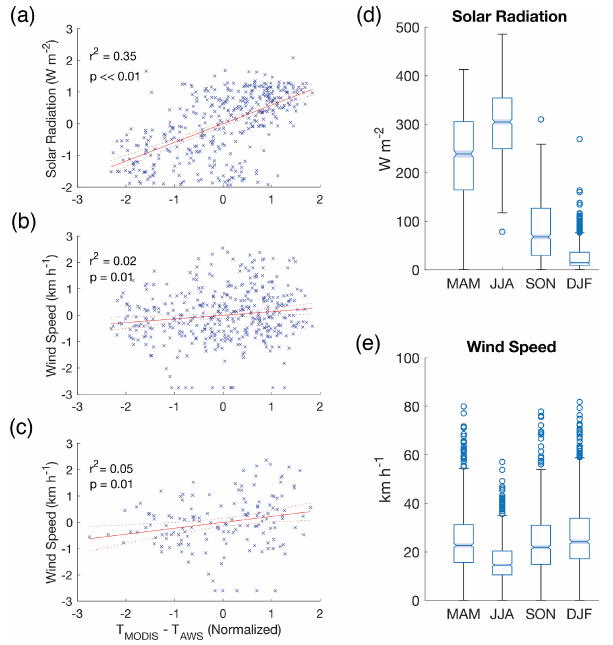
Figure 9. Linear regressions of the normalized MODIS LST off- set vs. (a) solar radiation, (b) wind speed and (c) wind speed under low-solar-radiation ( < 400Wm − 2 ) conditions. Boxplots of (d) so- lar radiation and (e) wind speed by season. The magnitude of the MODIS LST offset is more strongly related to solar radiation than to wind speed. Dashed red lines in regression plots indicate the 95% confidence interval around the regression line. Notches and shading in boxplots indicate the upper and lower bounds of each season’s median value of solar radiation or wind speed at the 95% confi- dence interval.